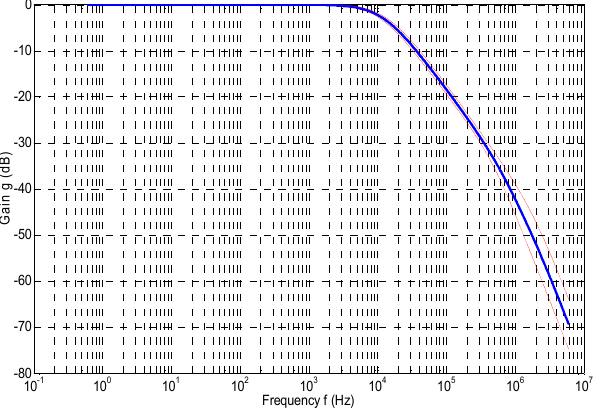
Figure 2. Gain g (dB) vs. frequency f (Hz).